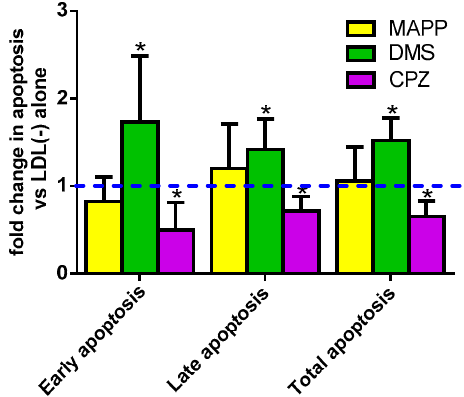
Figure 7. Apoptosis induced by LDL( − ) in the presence of inhibitors. Early, late, and total apoptosis induced by LDL( − ) (60 mg apoB/L) were evaluated in the absence or presence of MAPP (yellow bars), DMS (green bars), or CPZ (purple bars), all at 10 µM. Results are expressed as fold change in apoptosis versus LDL( − ) in the absence of inhibitors, mean ± SD ( n = 6), * vs. non-inhibitor, p < 0.05. However, MAPP and CPZ alone did not promote apoptosis in the absence of LDL( − ), whereas DMS did (Supplementary Table S1).